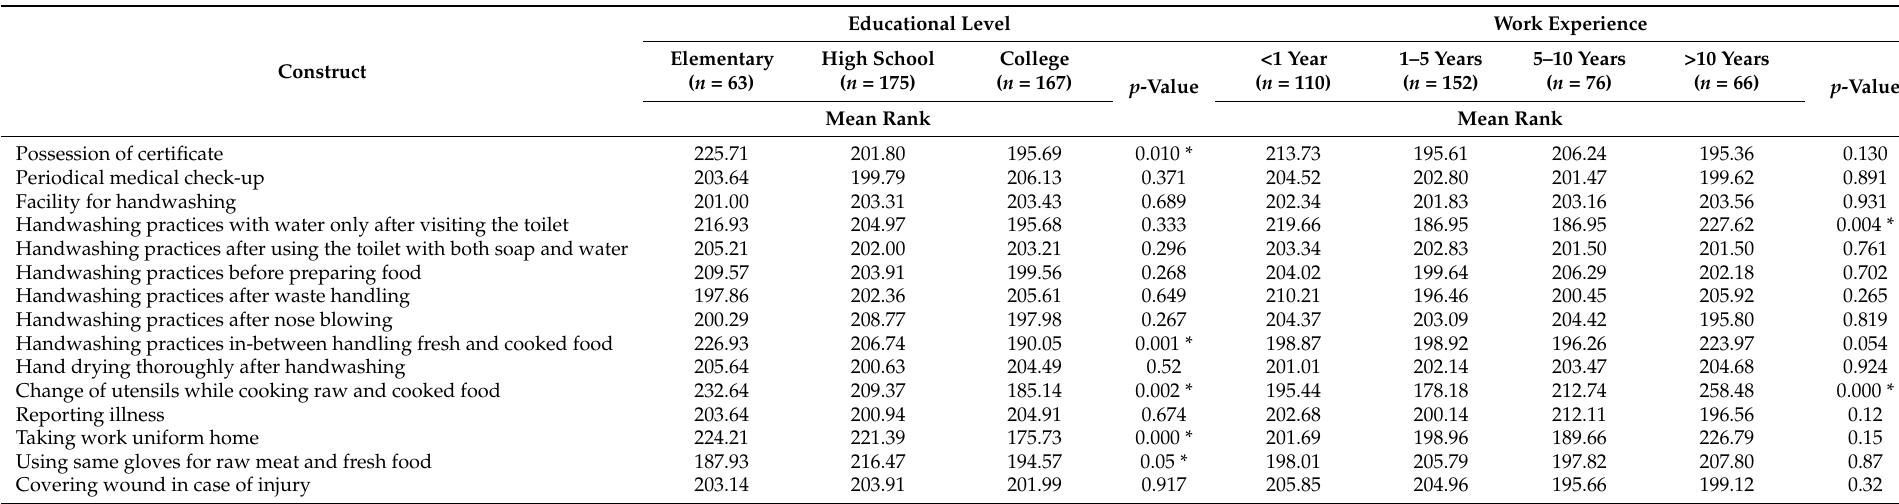
Table 7. Attribution of food safety and hygienic practices to educational level and work experience among healthcare and community food